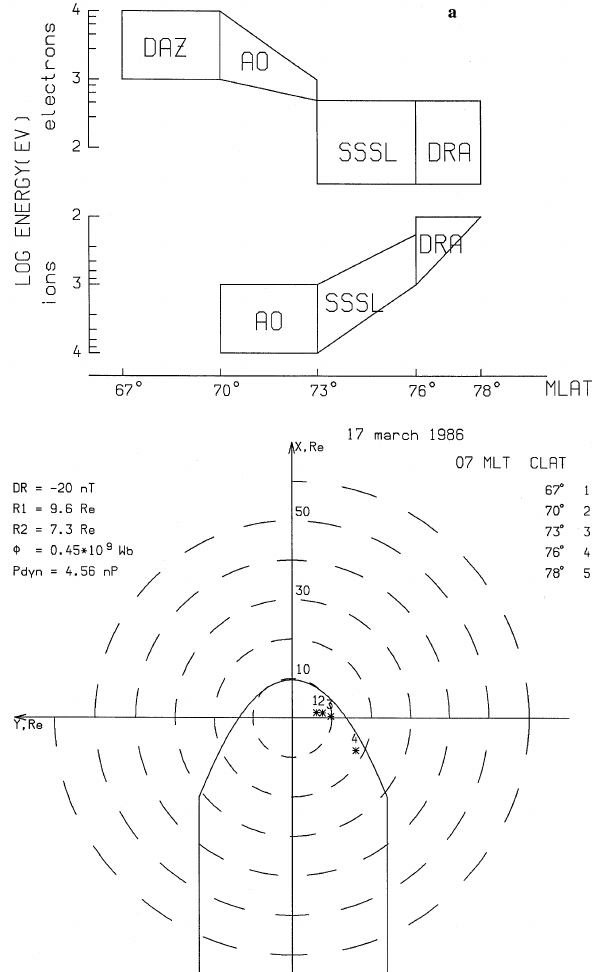
Fig. 16. Sketches showing the location of various particle precip- itation regimes in the dawn high-latitude region (upper panel) and corresponding plasma regime boundaries mapped to the outer mag- netospheric equatorial plane (lower